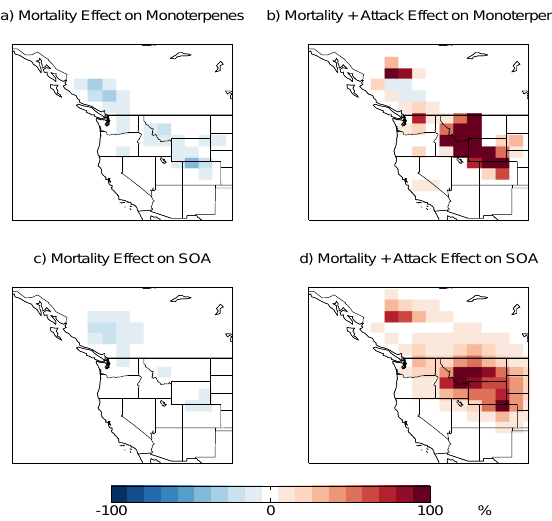
Fig. 9. Change in simulated summer-mean monoterpene emissions and summer-mean SOA concentrations from all four monoterpenes due to the impact of mountain pine beetle attack in 2008 for the spruce scenario (compare with Figs. 5c, 5f, 8c and 8f). (a) Change in monoterpene emissions due to mortality effect alone. (b) Change in monoterpene emissions due to mortality effect plus the attack effect. (c) Change in SOA concentrations due to the mortality effect. (d) Change in SOA concentrations due to the mortality effect plus the attack effect. The color bar is saturated at